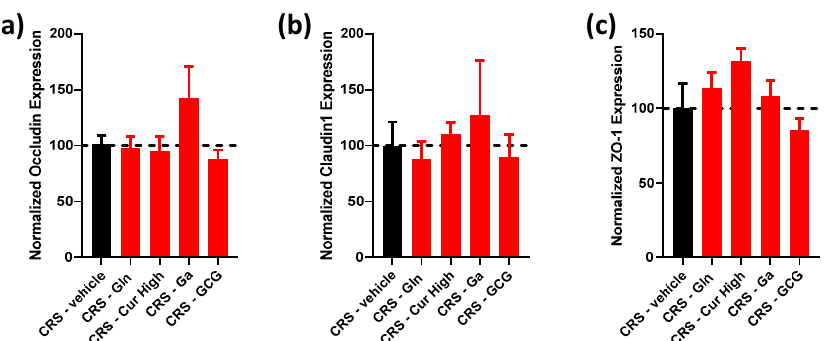
Figure 4. Effect of each selected compound administered individually and the GCG mix on colonic tight-junction protein gene expression. ( a ) Normalized occludin, ( b ) claudin-1 and ( c ) ZO-1 gene expression in CRS (black bars) vs. CRS-Glutamine (Gln), CRS-Curcuméga ® (Cur) at high and low doses, CRS-Gabolysat ® (Ga) and CRS-GCG groups (red bars). n = 7–16 per group. Data are presented as means ± SEM. Data were compared by one-way ANOVA with Dunnett’s post hoc tests. Dashed line represents the level observed in untreated CRS mice.